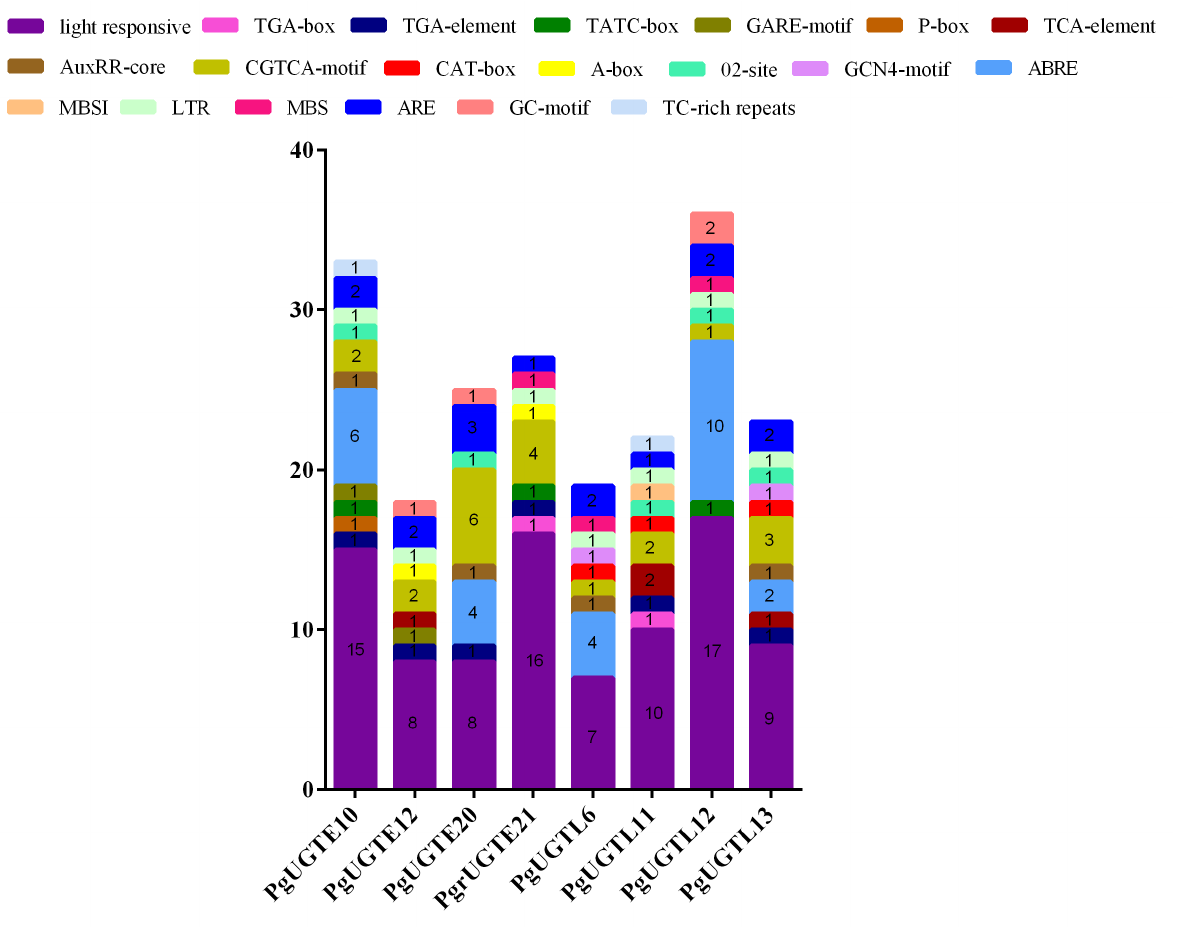
Figure 5. CREs of the candidate PgUGT s. The CREs are displayed in different colored boxes. The number of each CRE in the gene is displayed in the boxes.